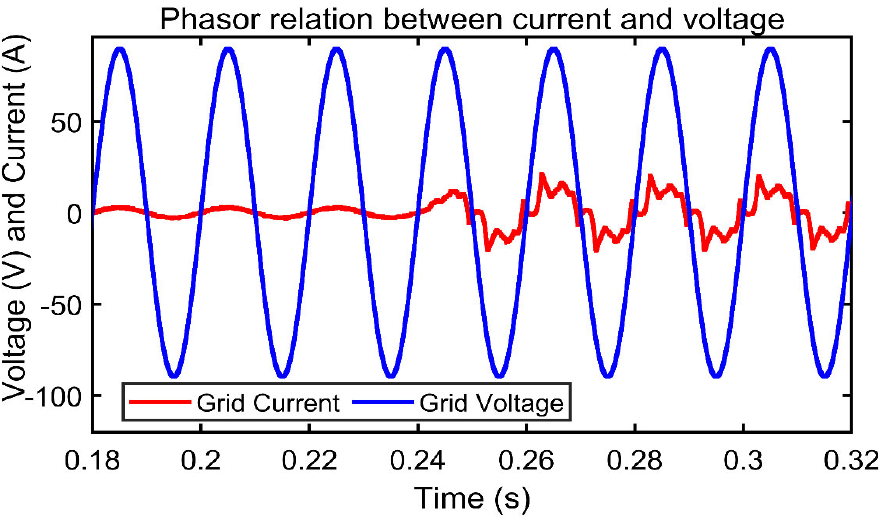
Figure 9. Phasor relation between grid current and grid voltage.